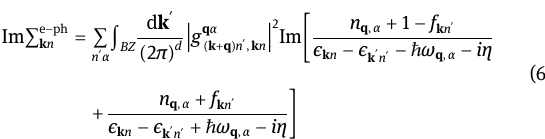
Figure 1: Optimized lattice structures of borophene monolayer. (a) Top and side views of the optimized lattice structures of borophene monolayer. The area enclosed by a black rectangle correspondstoaunitcellofborophene.(b)ThefirstBrillouinzoneof borophene monolayer, the irreducible k -point path Γ - X -M- Y - Γ -M is used for calculating its band structure and phonon